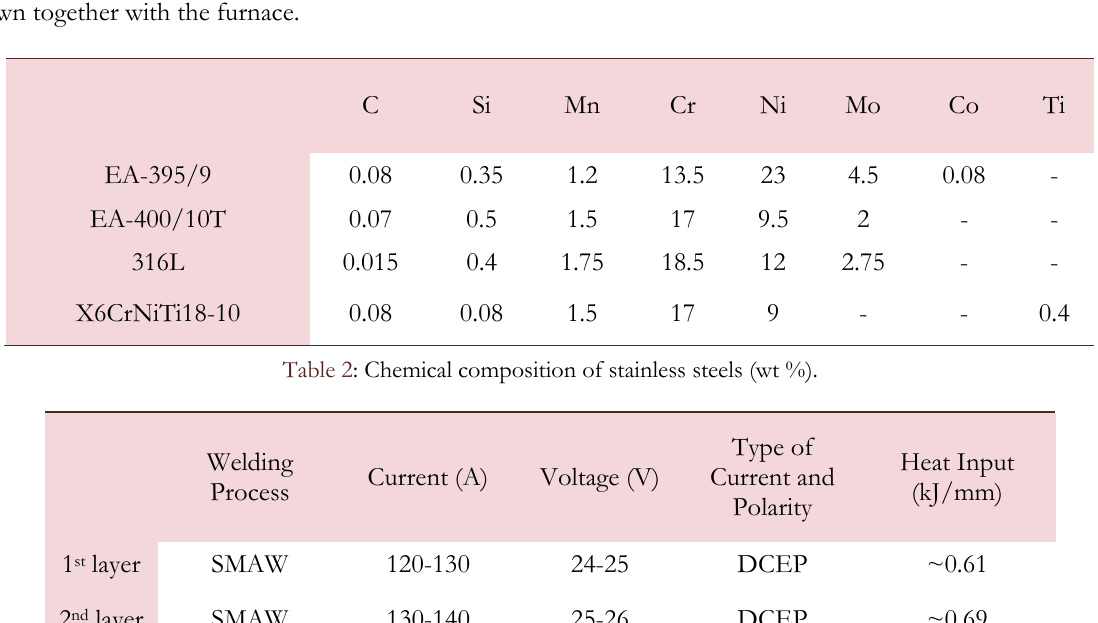
Table 3. After cladding, the specimen was heat treated by heating it up to 670°C at a rate of 50°C/h for 16 hours and let it cool down together with the furnace.